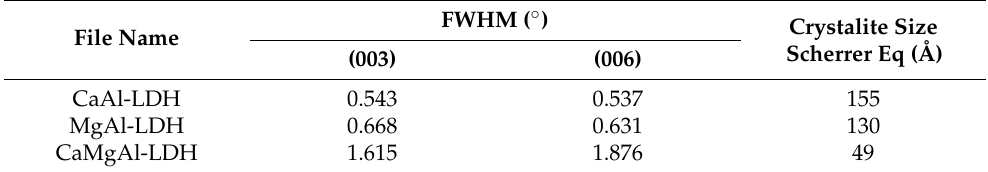
Table 2. The XRD parameters for the LDHs.